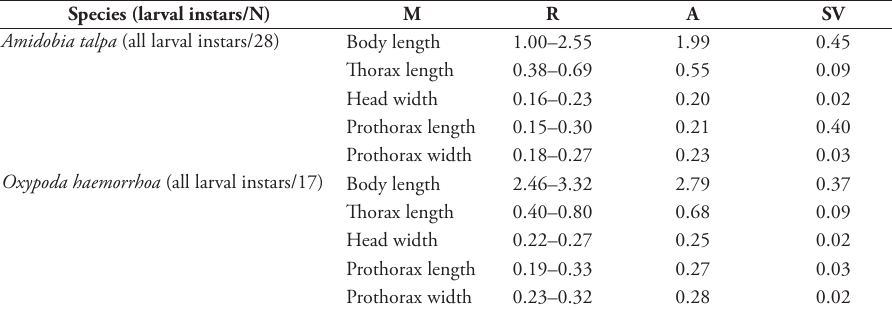
Table 1. Measurements of larval instars of Amidobia talpa and Oxypoda haemorrhoa . Symbols and ab- breviations: larval instars, A – average, N – number of specimens examined, M – measurement, R – range, SV – standard